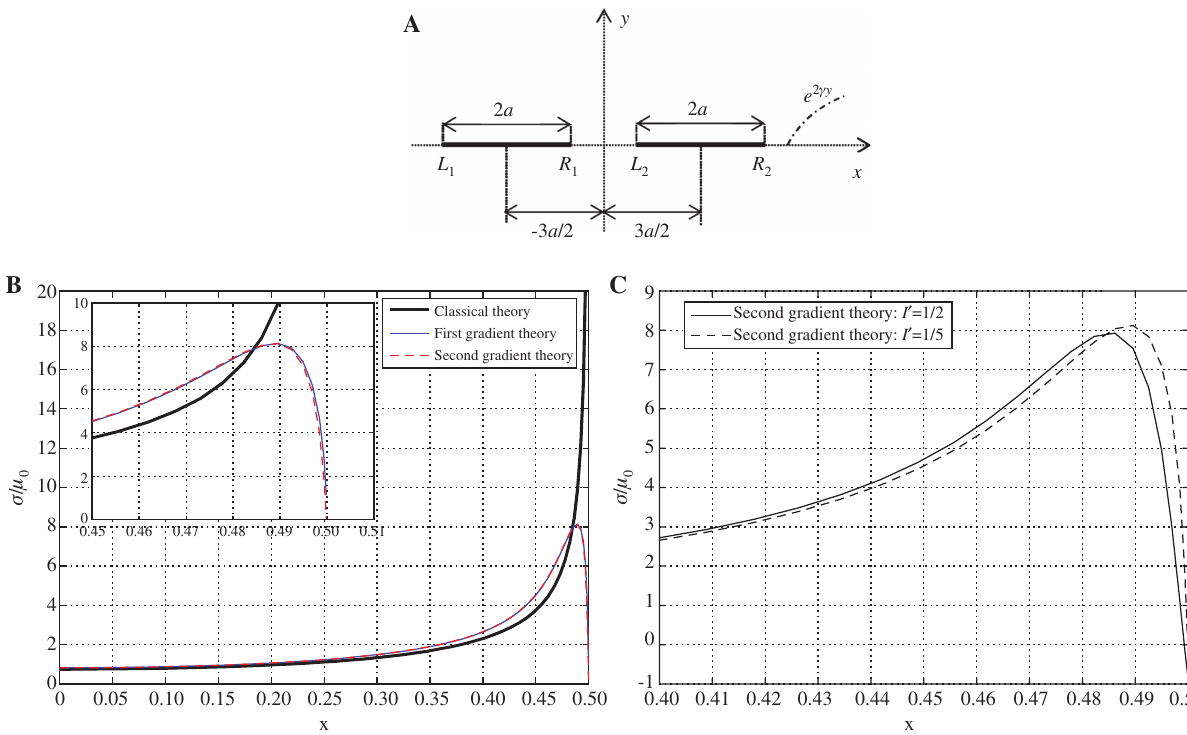
Figure 2 (A) Geometry of the functionally graded medium with two collinear cracks. (B) Normalized stress distribution for a graded plane with two collinear horizontal cracks ( γ a = 2, l = 0.01 a , l ′ = l /5). (C) Normalized stress distribution for a graded plane with two collinear horizon- tal cracks ( γ a = 2, l = 0.01 a ) in second gradient elasticity: l ′ = l /5, l